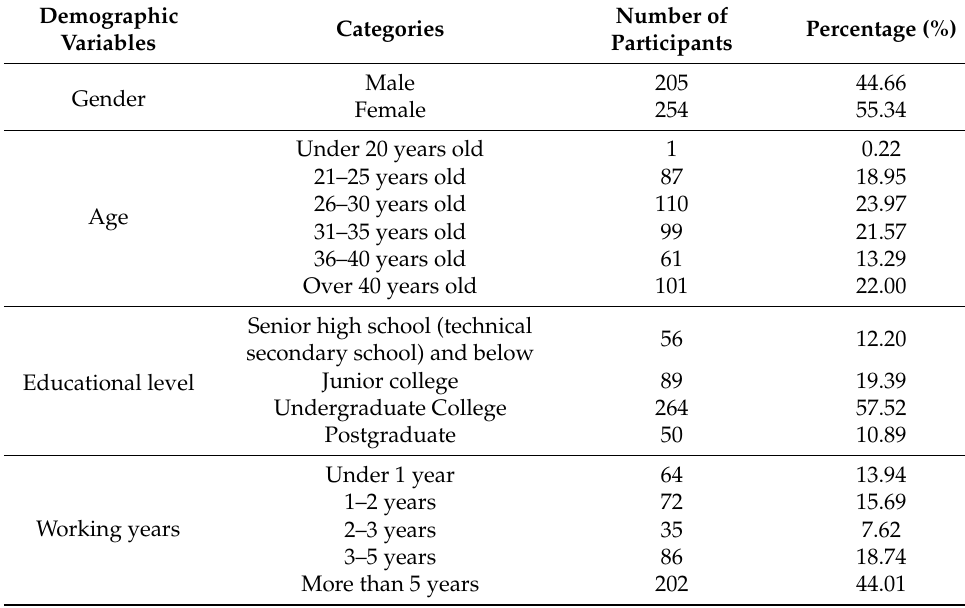
Table 1. The demographics of the sample ( N =